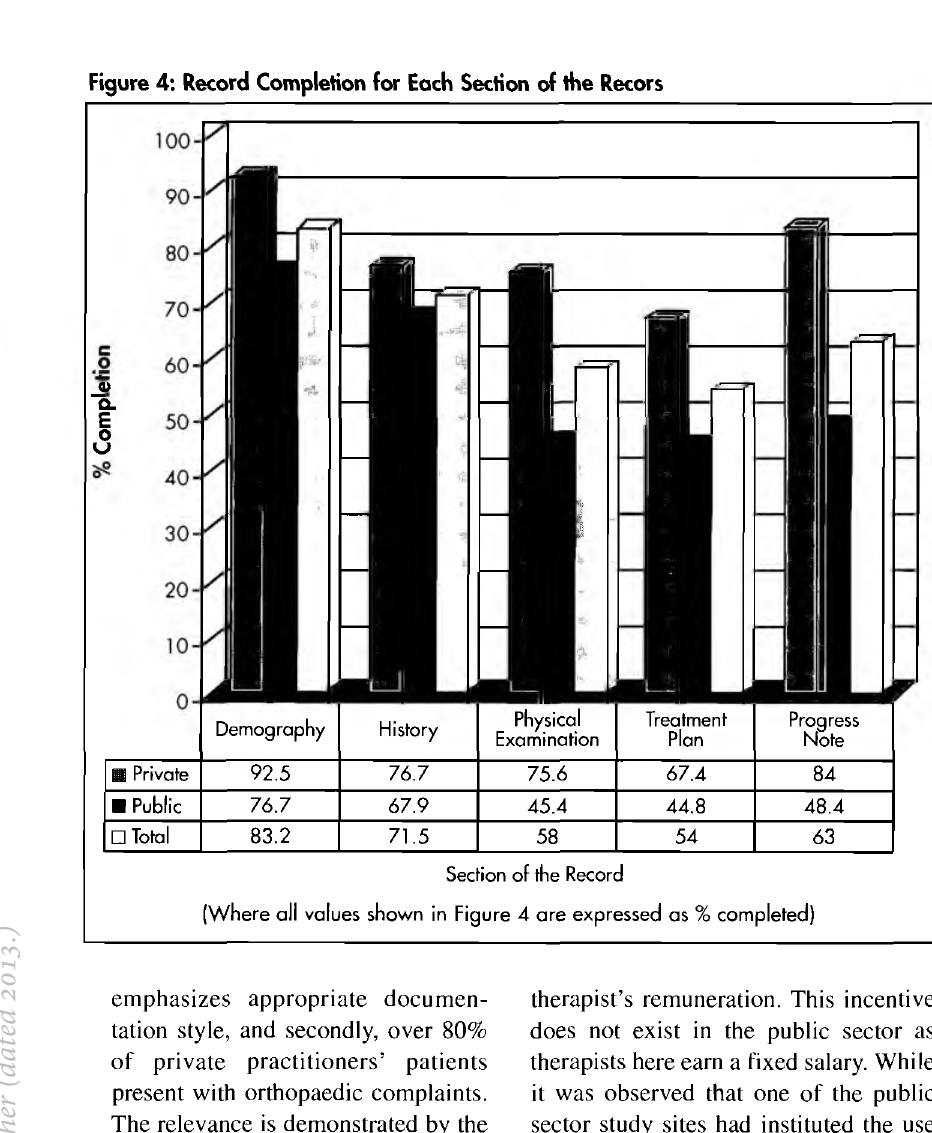
Figure 4: Record Completion (or Each Section of the Recors